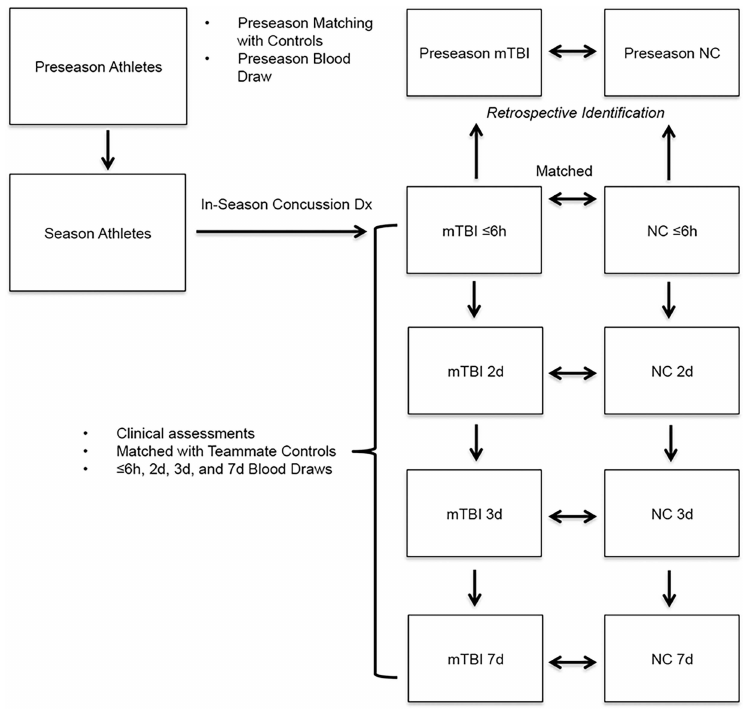
Fig 1. College Athlete cohort–metabolomic biomarker study design. In the college athlete cohort (Athletes), the mTBI (mild traumatic brain injury) and NC (non-concussed control) groups were definitively identified as a result of longitudinal clinical assessment of study participants throughout their sports seasons. Identification of mTBI during the Season allowed retrospective designation of group participants in the Preseason. Analytic timepoints following mTBI occurrence are indicated as (cid:20) 6h = (cid:20) 6 hours; 2d = 2 days; 3d = 3 days; and 7d = 7